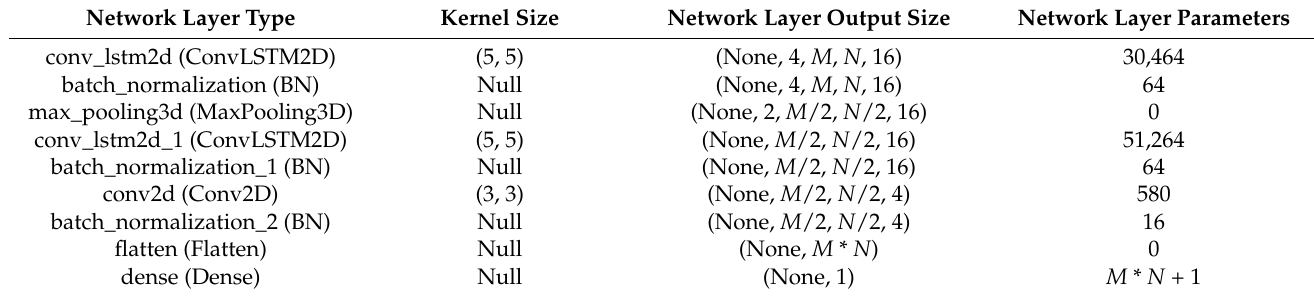
Table 2. Network structure parameter information table of the ConvLSTM